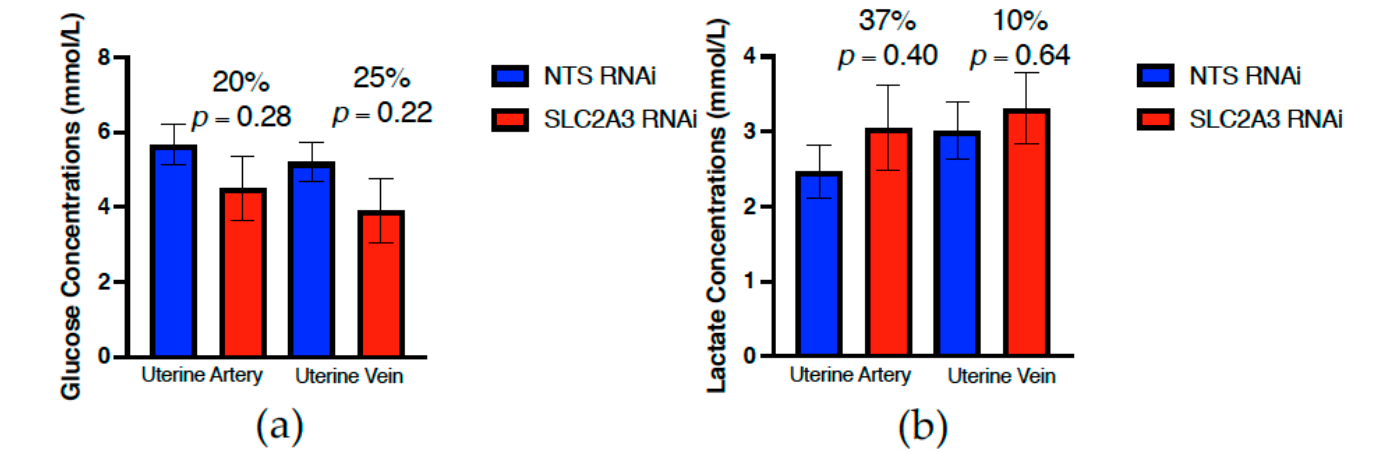
Figure 3. Impact of SLC2A3 RNAi on both uterine artery and vein concentrations of ( a ) glucose and ( b ) lactate in plasma samples harvested at 75 dGA. Data are shown as means ± SEM. NTS, non-targeting sequence; RNAi, RNA interference.